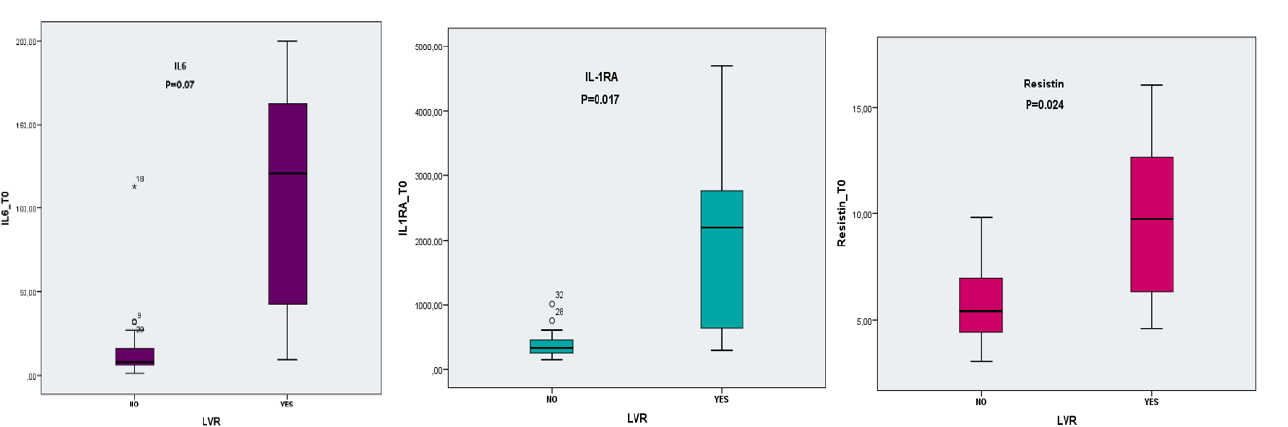
Table 4. Univariate binary logistic regression for cytokines to assess the ability to predict LVR.